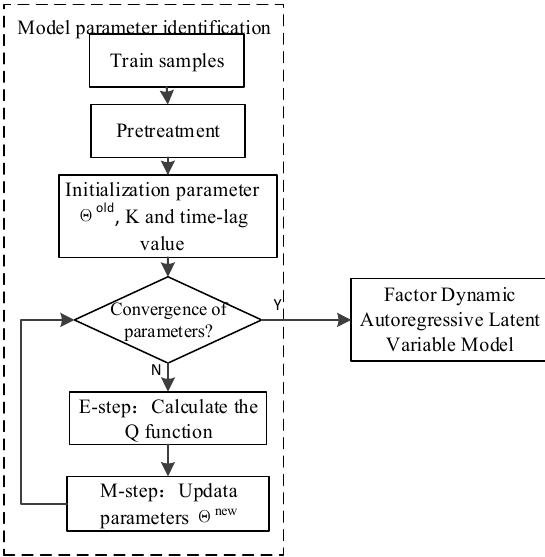
Figure 4. The flow chart of model training.